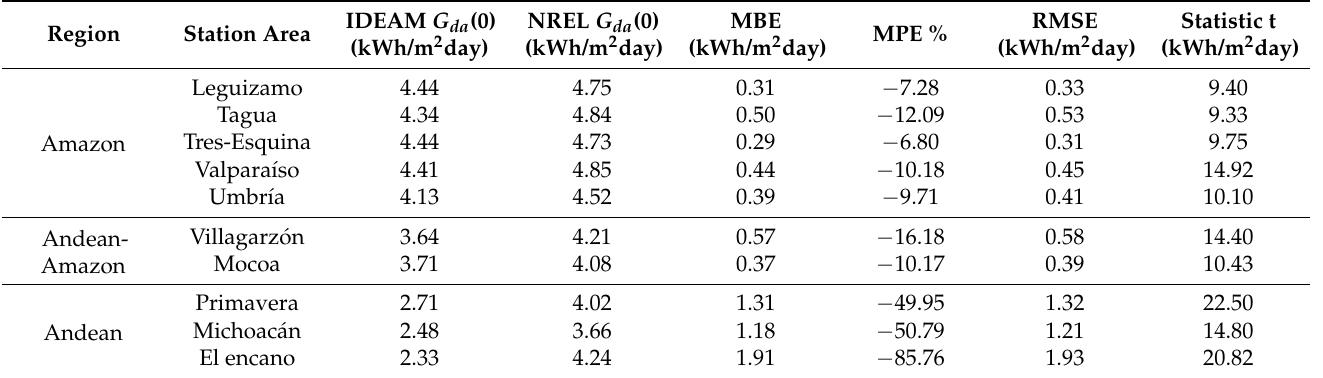
Table 3. Comparison of irradiation values G da from IDEAM weather stations and NREL remote sensor data. Region Station